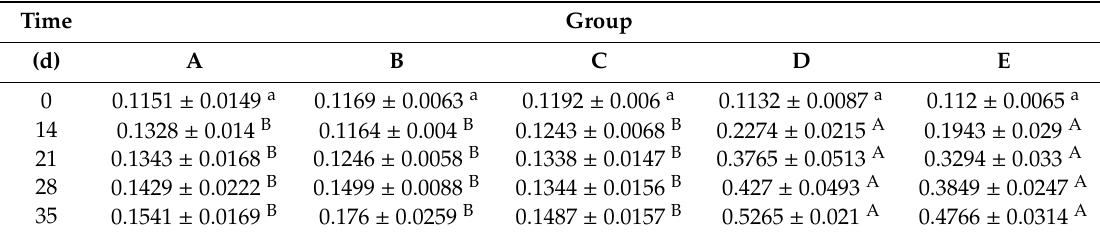
Table 1. The OD 450 of serum IgG levels before and after immunizations.